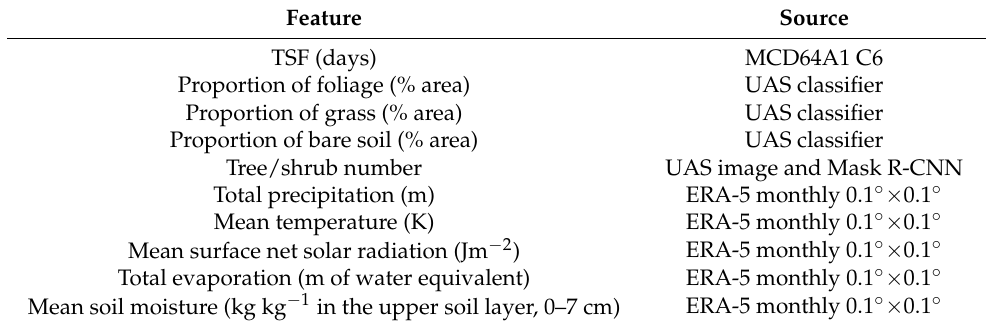
Table 2. Features used in modelling the FL. A single, mean value for every feature was computed for each plot. Averages and sums of meteorological variables from ERA-5 were taken spanning from the date of the last previous fire detected at a given location and the date the measurements were taken.